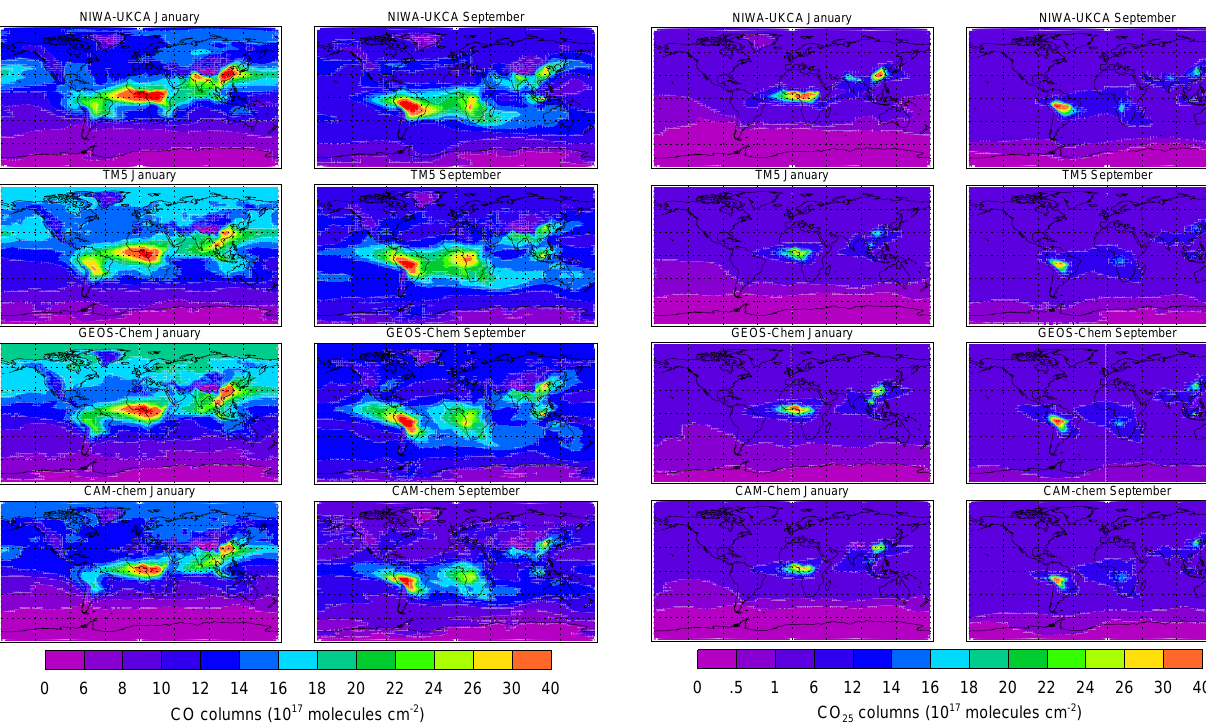
Figure 11. Tropospheric CO columns from the four models for Jan- uary (left) and September (right) 2005, for the CLM-MEGANv2.1 simulations.